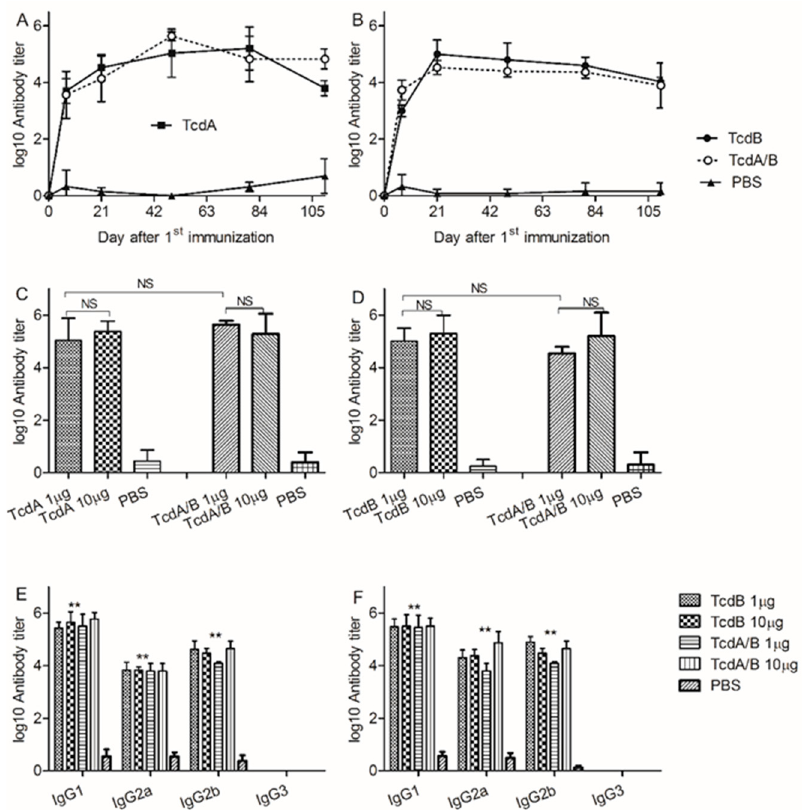
Figure 3. The immunogenicity of vaccine candidates. ( A ) Anti-RBD-TcdA antibody titers at different time points (1 μ g group). ( B ) Anti-RBD-TcdB antibody titers at different time points (1 μ g group). ( C ) Anti-RBD-TcdA antibody titers on day 49. ( D ) Anti-RBD-TcdB antibody titers on day 21. ( E ) Antibody